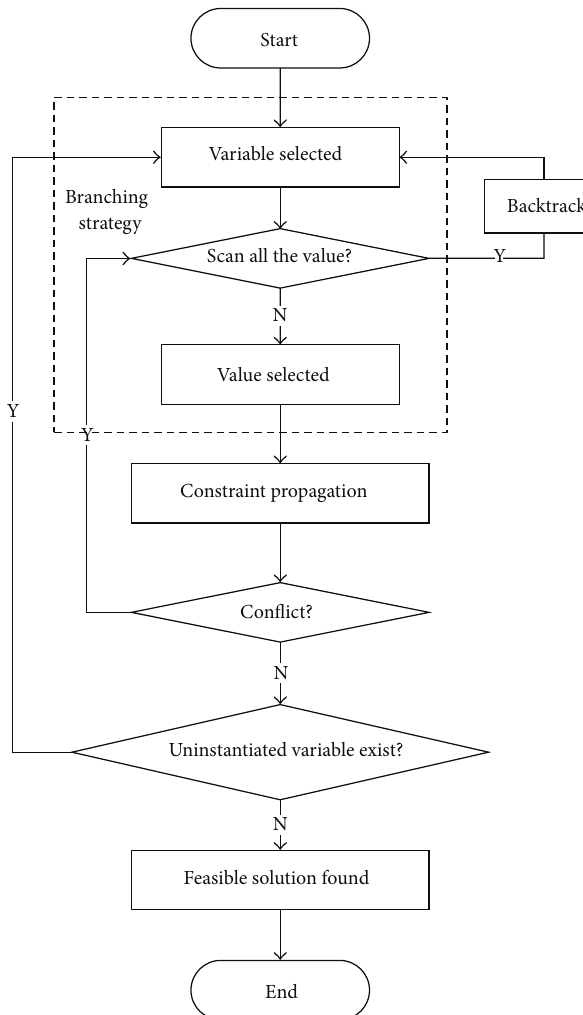
Figure 2: Flow chart of CSP solving